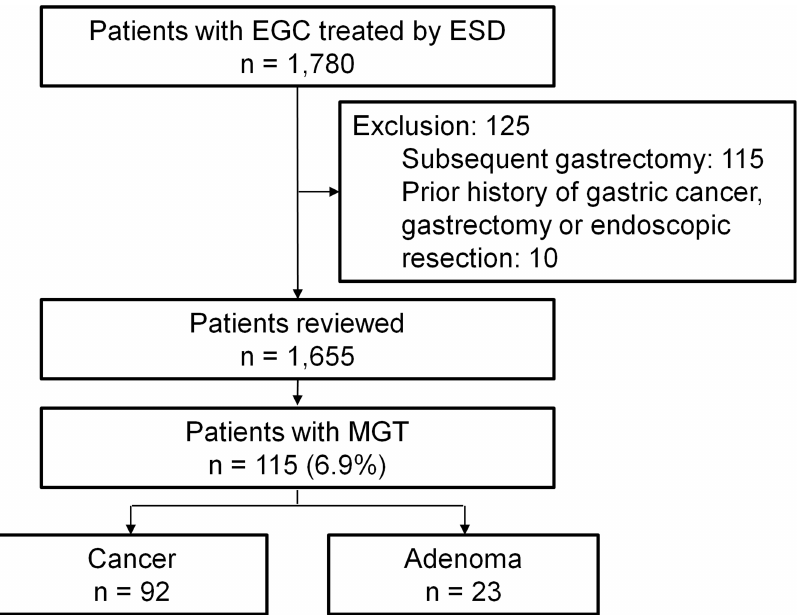
Fig 1. Overviewof patient selection process. Inclusionand exclusioncriteria for enrolledpatients are shown. EGC, early gastric cancer; ESD, endoscopic submucosal dissection;MGT, metachronous gastric